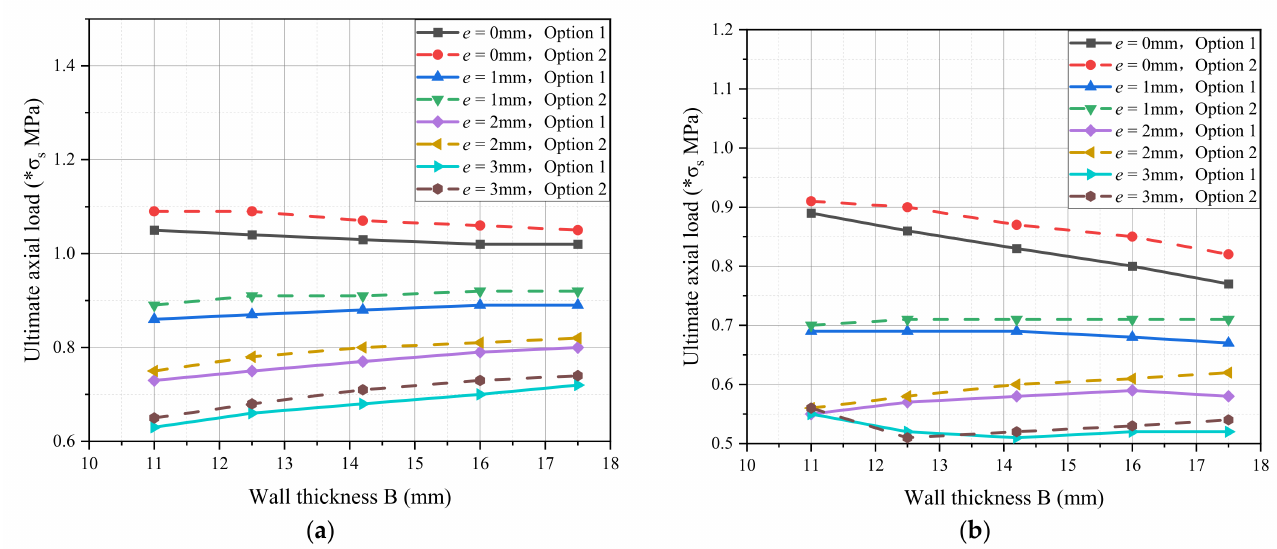
Figure 13. Effects of wall thicknesses and misalignment on the ultimate axial load of pipeline girth weld cracks. ( a ) a/B = 0.1; 2 c/ π D = 0.01; ( b ) a/B = 0.3; 2 c/ π D =